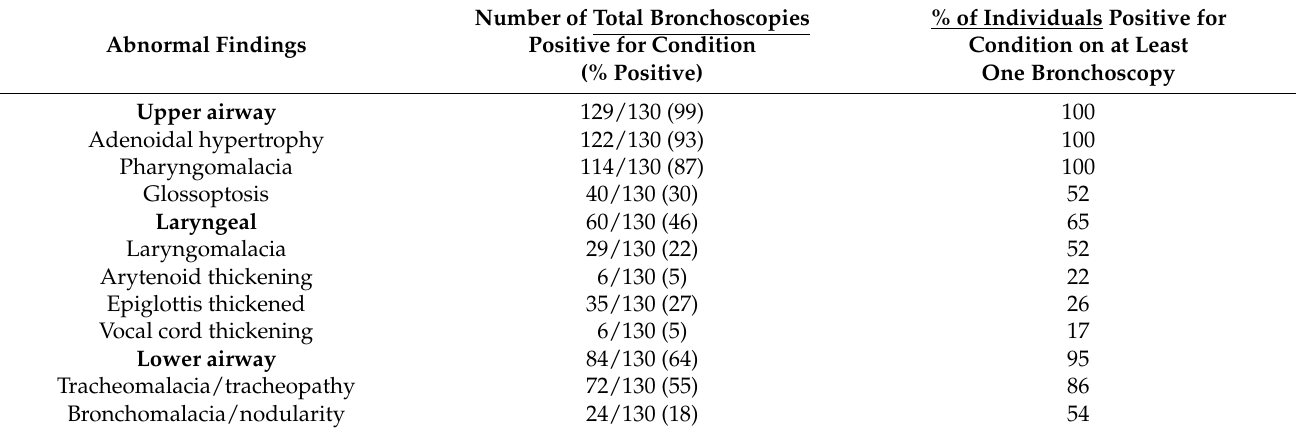
Legend Table 1: Data are presented for each bronchoscopy including repeat bronchoscopies in subjects with multiple procedures. The column on the left described the proportion of every bronchoscopy performed which was positive for each listed condition. The column on the right describes the percentage of subjects who had the listed finding on at least one